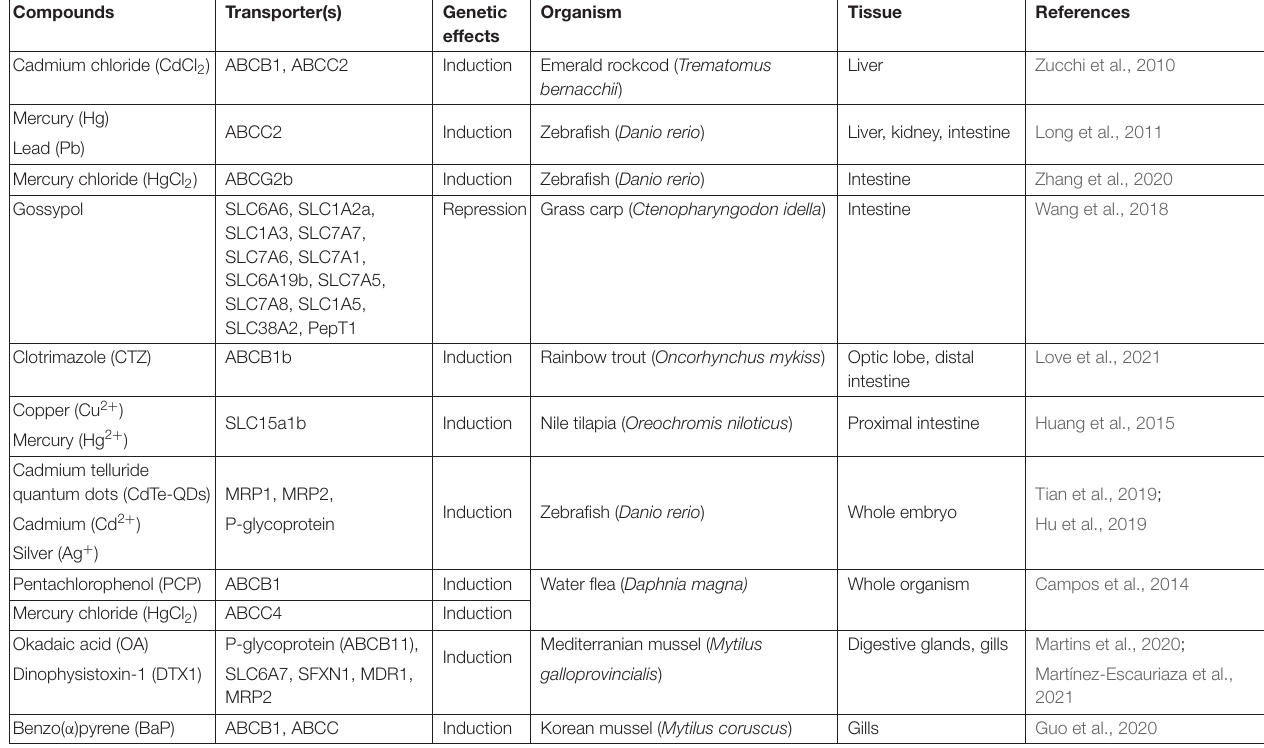
TABLE 1 | List of tissue specific MXR transporter gene induction or repression by environmental chemicals, heavy metals, and natural toxins.